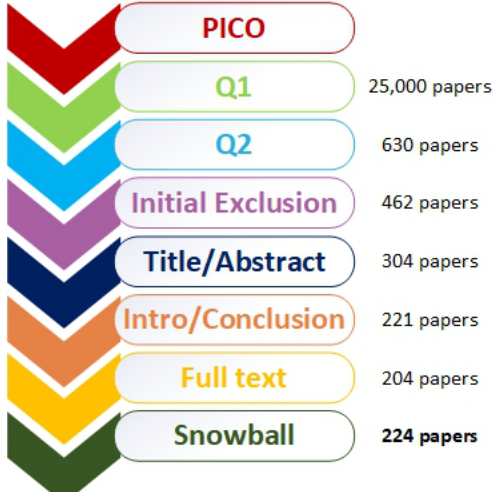
Figure 3. Methodology steps for paper selection and how many papers were left at each exclu- sion/inclusion